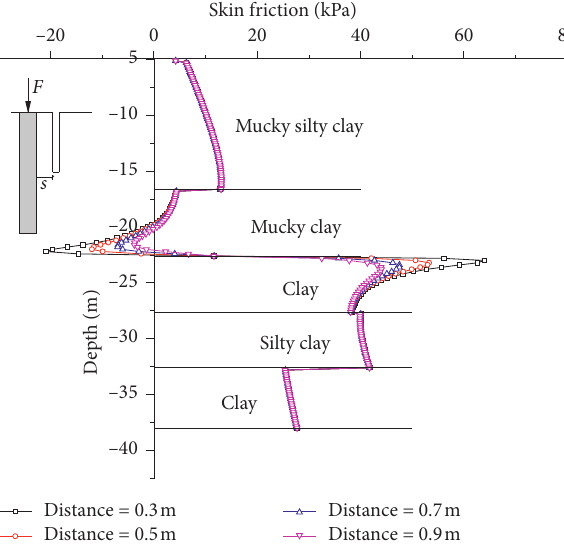
Figure 10: Effect of distance of drilling borehole on the skin friction of the existing foundation